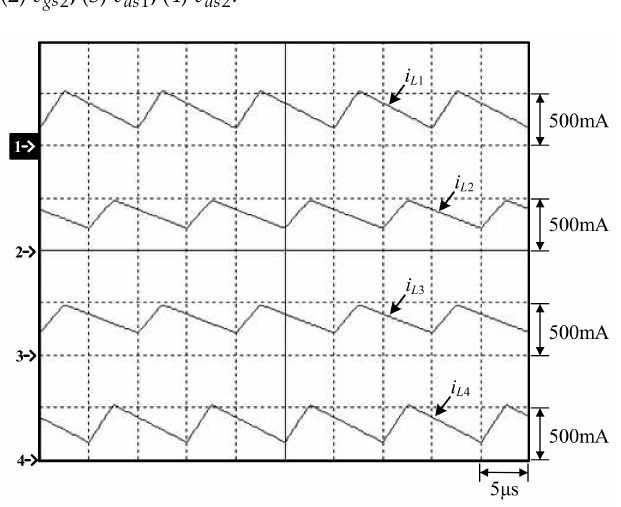
Figure 31. Simulated waveforms relevant to different numbers of LEDs for LED strings: (1) v gs 1 ; (2) v gs 2 ; (3) v ds 1 ; (4) v ds 2 .